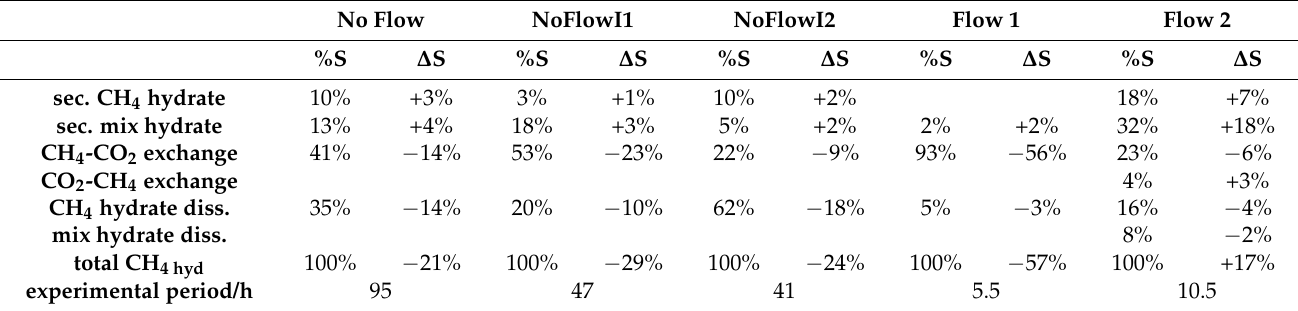
Table 1. The percentage of the initial CH 4 hydrate signal (%S) that was attributed to the respective individual processes and the contribution of these processes to the change of the total CH 4 hydrate signal ( ∆ S). %S and ∆ S for total CH 4 hydrate are consequently (within the range of rounding errors) the sum of the values for all subprocesses. See text for further explanations. Flow 1 is the flow period of experiment Flow and Flow 2 is the no-flow period of experiment Flow . The duration of the experimental period is given in the last row.